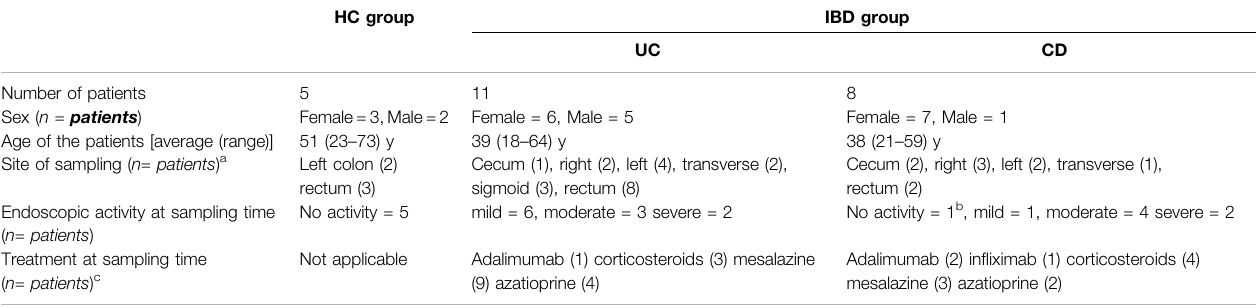
TABLE 1 | Clinical features of healthy control (HC) and IBD patient groups.